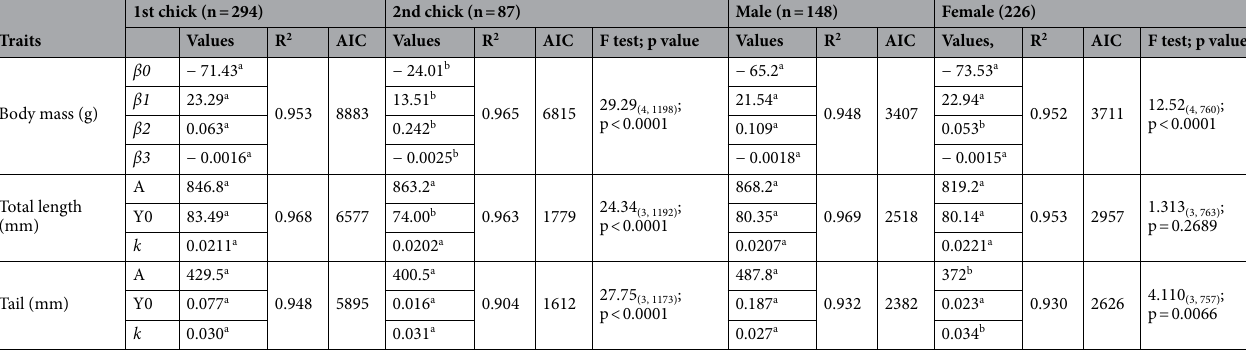
Table 4. Parameter results from two models fitted to growth of first and second chicks, male, and female of normal-sized hyacinth macaws. Cubic polynomial model ( β0 = intercept, β 1 = maximum relative growth rate, β2 = upper asymptote, β3 = weight loss begins) and Gompertz model (A = upper asymptote, i.e. predicted adult size), k maximum relative growth rate, Y0 initial value). *Values follow of different letters are significant to p <